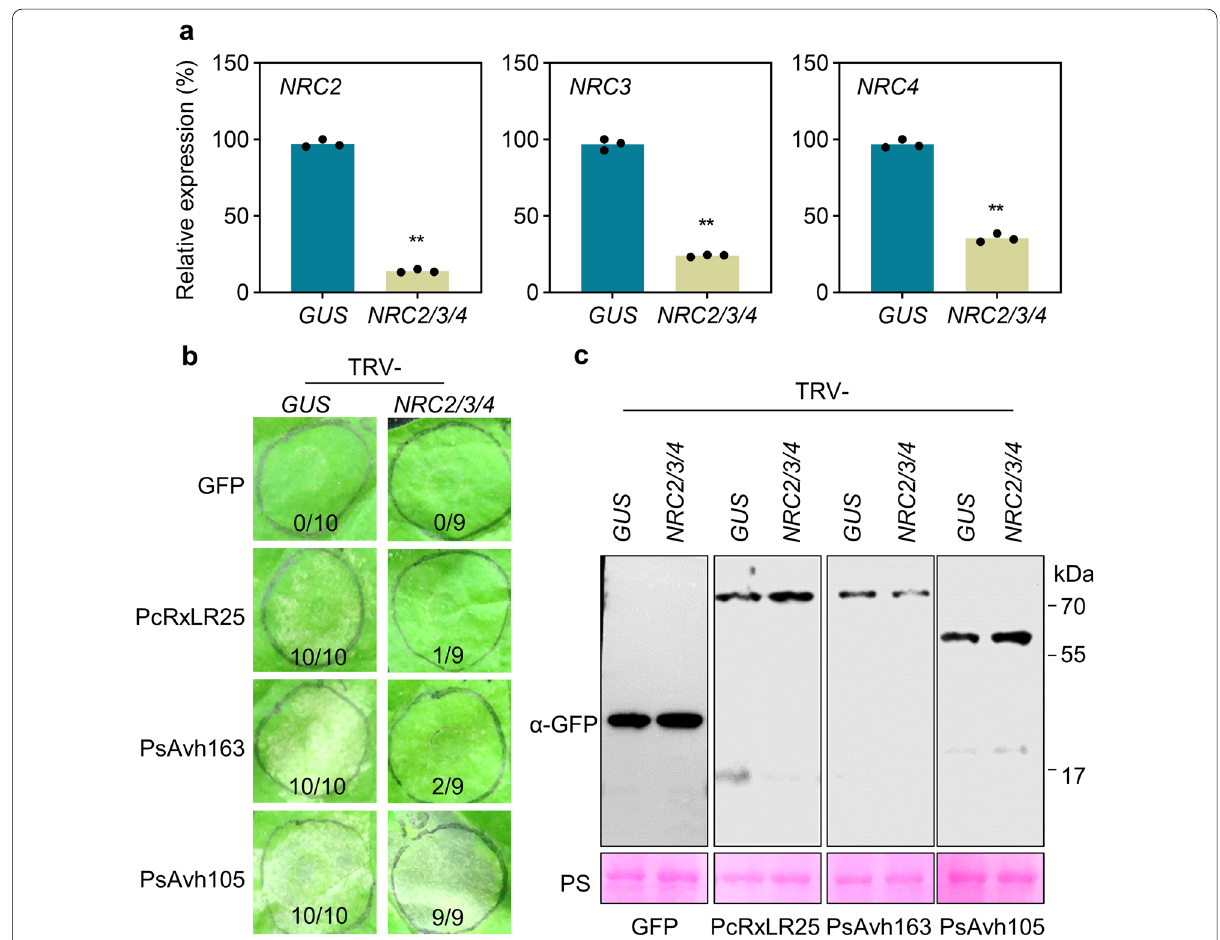
Fig. 5 Silencing NbNRC2 , NbNRC3 and NbNRC4 simultaneously attenuates the cell death triggered by PcRXLR25 and PsAvh163 in N. benthamiana. a Silencing efficiency of NbNRC2 , NbNRC3 and NbNRC4 . Values represented average t-test. b Transient expression of GFP, PcRXLR25, PsAvh163 and PsAvh105 in GUS - and NRC2/3/4 -silenced plants . GFP was used as a negative control. Consistent results were observed from three independent biological experiments. Numbers represent the number of leaves showing cell death out of the number of leaves analyzed. c The accumulation of GFP, PcRxLR25, PsAvh163 and PsAvh105 in GUS - and NRC2/3/4 -silenced plants. GFP was used as a negative control. Total protein loading was confirmed by Ponceau S